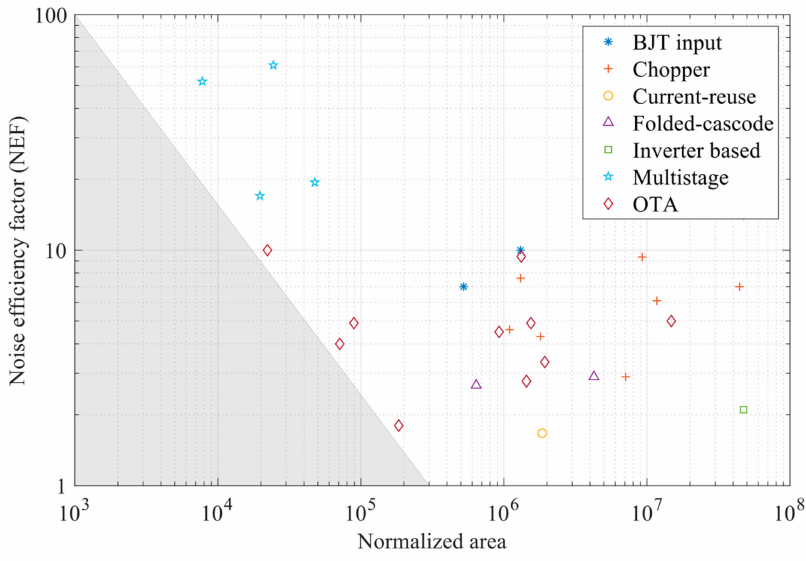
Figure 6. Comparison of the NEF and the normalized area per channel. The gray marked area shows a potential for improvement in biomedical amplifier